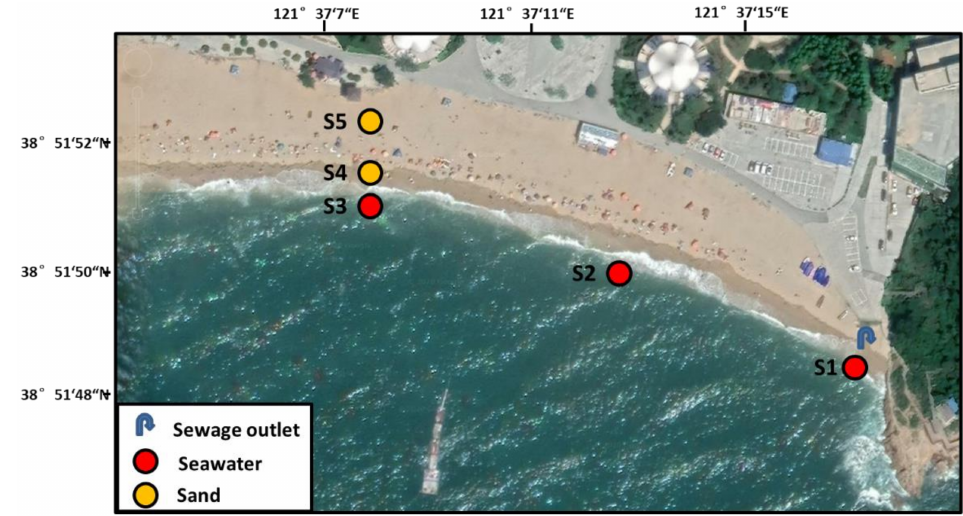
Figure 1. Sampling locations in Fujiazhuang bathing beach in Dalian,